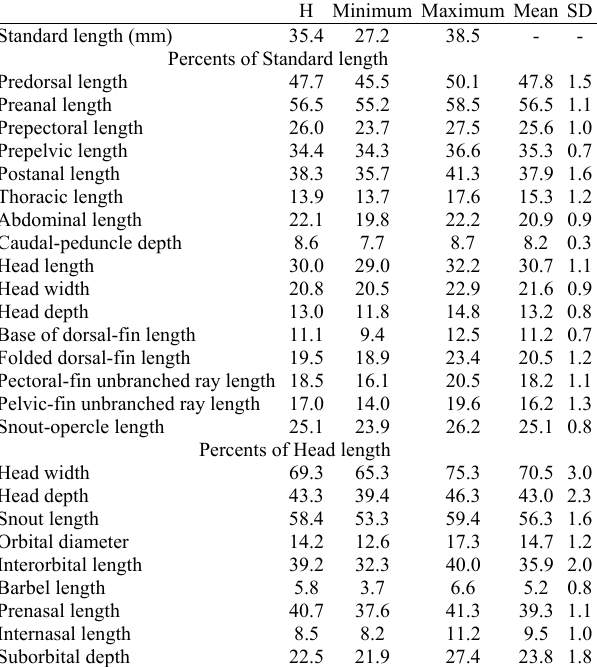
Table 5. Descriptive morphometrics of Rhinolekos schaeferi . Values given for holotype (H; MCP 26939) and ranges of 13 specimens (DZSJRP 12192; MCP 44056); range includes holotype. SD = Standard deviation.